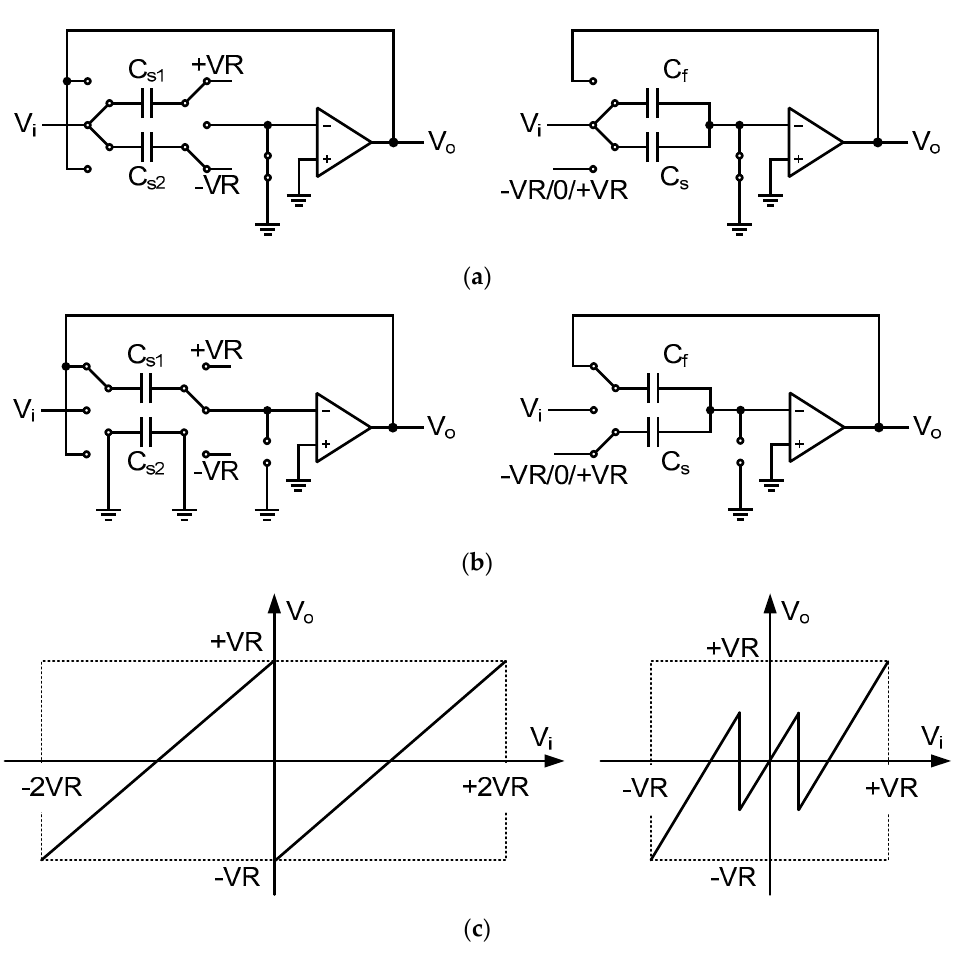
Figure 1. ( a ) Sampling phase; ( b ) Hold phase; ( c ) Transfer curve for 1-bit FADAC ( left ) and 1.5-bit MDAC ( right ). Table 1. Performance comparison for 1.5-bit MDAC and 1-bit FADAC.